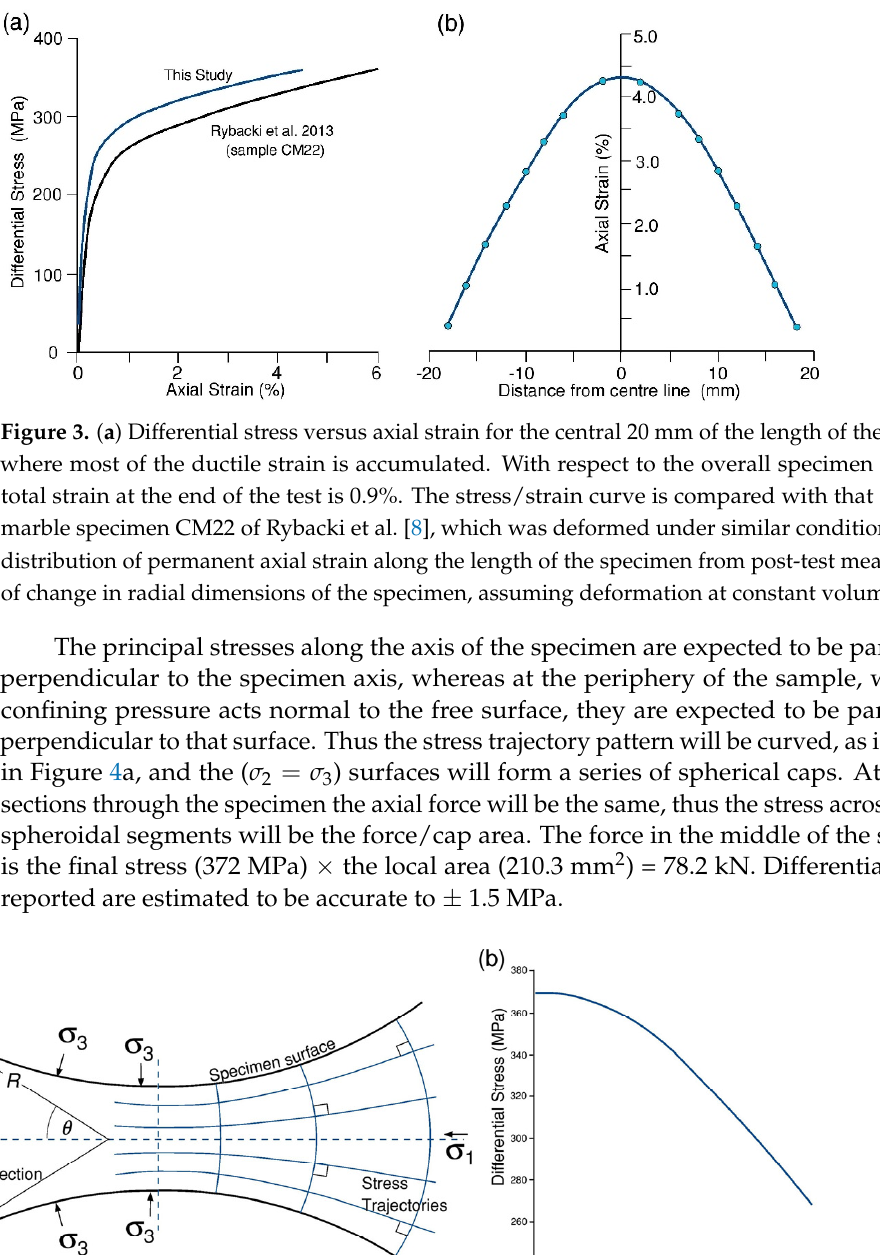
Figure 4. ( a ) Schematic illustration of the form of the principal stress trajectories within the specimen. The axial force is distributed over the area of the ( σ 2 = σ 3 ) segments of spherical surfaces, the area of each of which is a function of x and must be calculated in order to determine the local σ 1 ( x ) ; ( b ) Calculated variation of axial stress σ 1 with distance from the centre of the specimen, where the axial stress is highest.